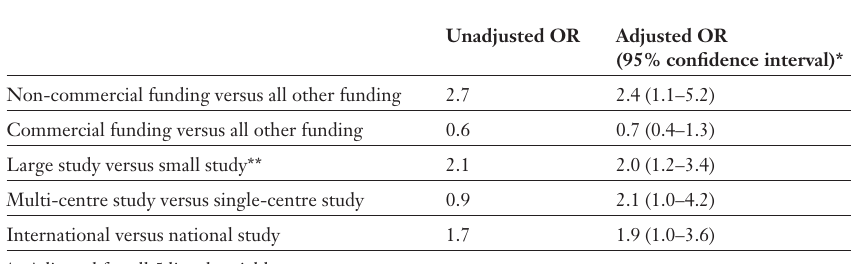
Table 2 Probability of publi- cation according to study characteristics.